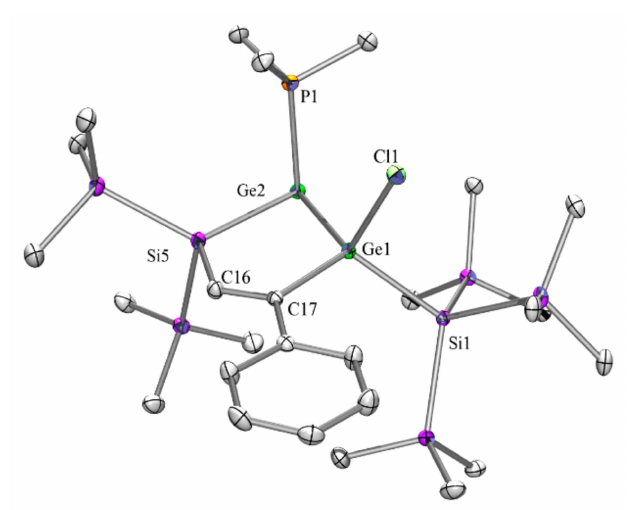
Figure 3. Molecular structure of 5 (thermal ellipsoid plot drawn at the 30% probability level). All hydrogen atoms omitted for clarity (bond lengths in Å, angles in deg). Ge(1)–C(17) 1.997(2),